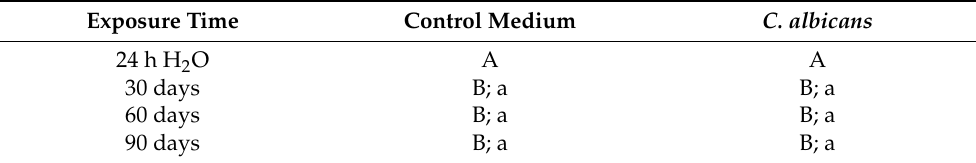
Table 1. The results of the Tukey HSD post hoc tests (columns) and the Student t -tests (rows) for the ball hardness.